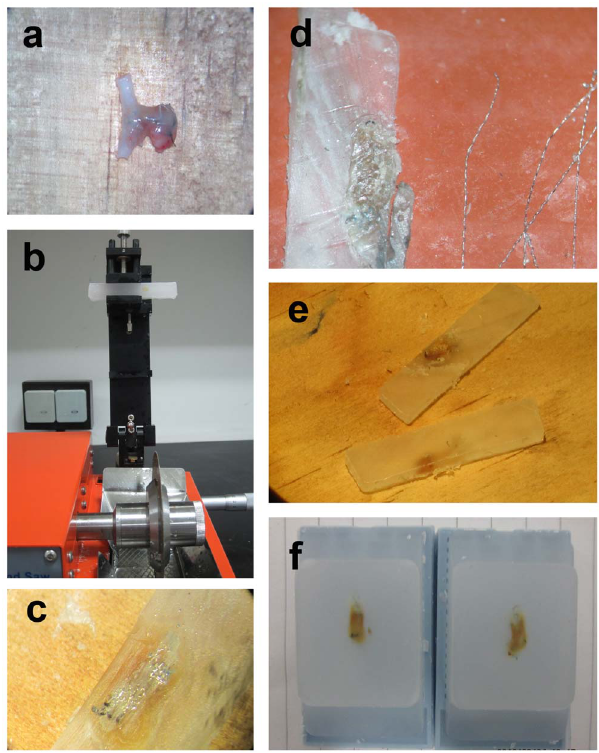
Figure 1. Embolization aneurysm specimen handling process. ( a ) specimens obtained after cell transplantation for about 6 weeks ( b ) tissues were sectioned using an isomet low speed saw at 1000 m m intervals in a coronal orientation after being dehydrated and embedded ( c ), the tissue slices contained a large amount of coils under the microscope ( d ), the coils were extracted carefully by micro-tweezers under the microscope ( e ), after coil extraction and re-embedding, the tissue sections were processed into 5 mm slices by a